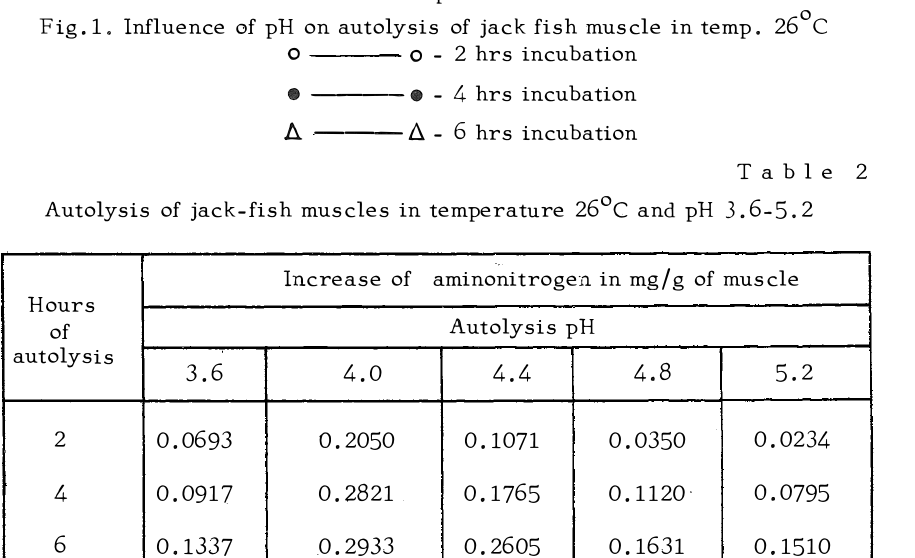
Fig .1. Influence of pH on autolysis of jack fish muscle in temp. 26 ° C o o - 2 hrs incubation • ----e - 4 hrs incubation A ---fl - 6 hrs incubation